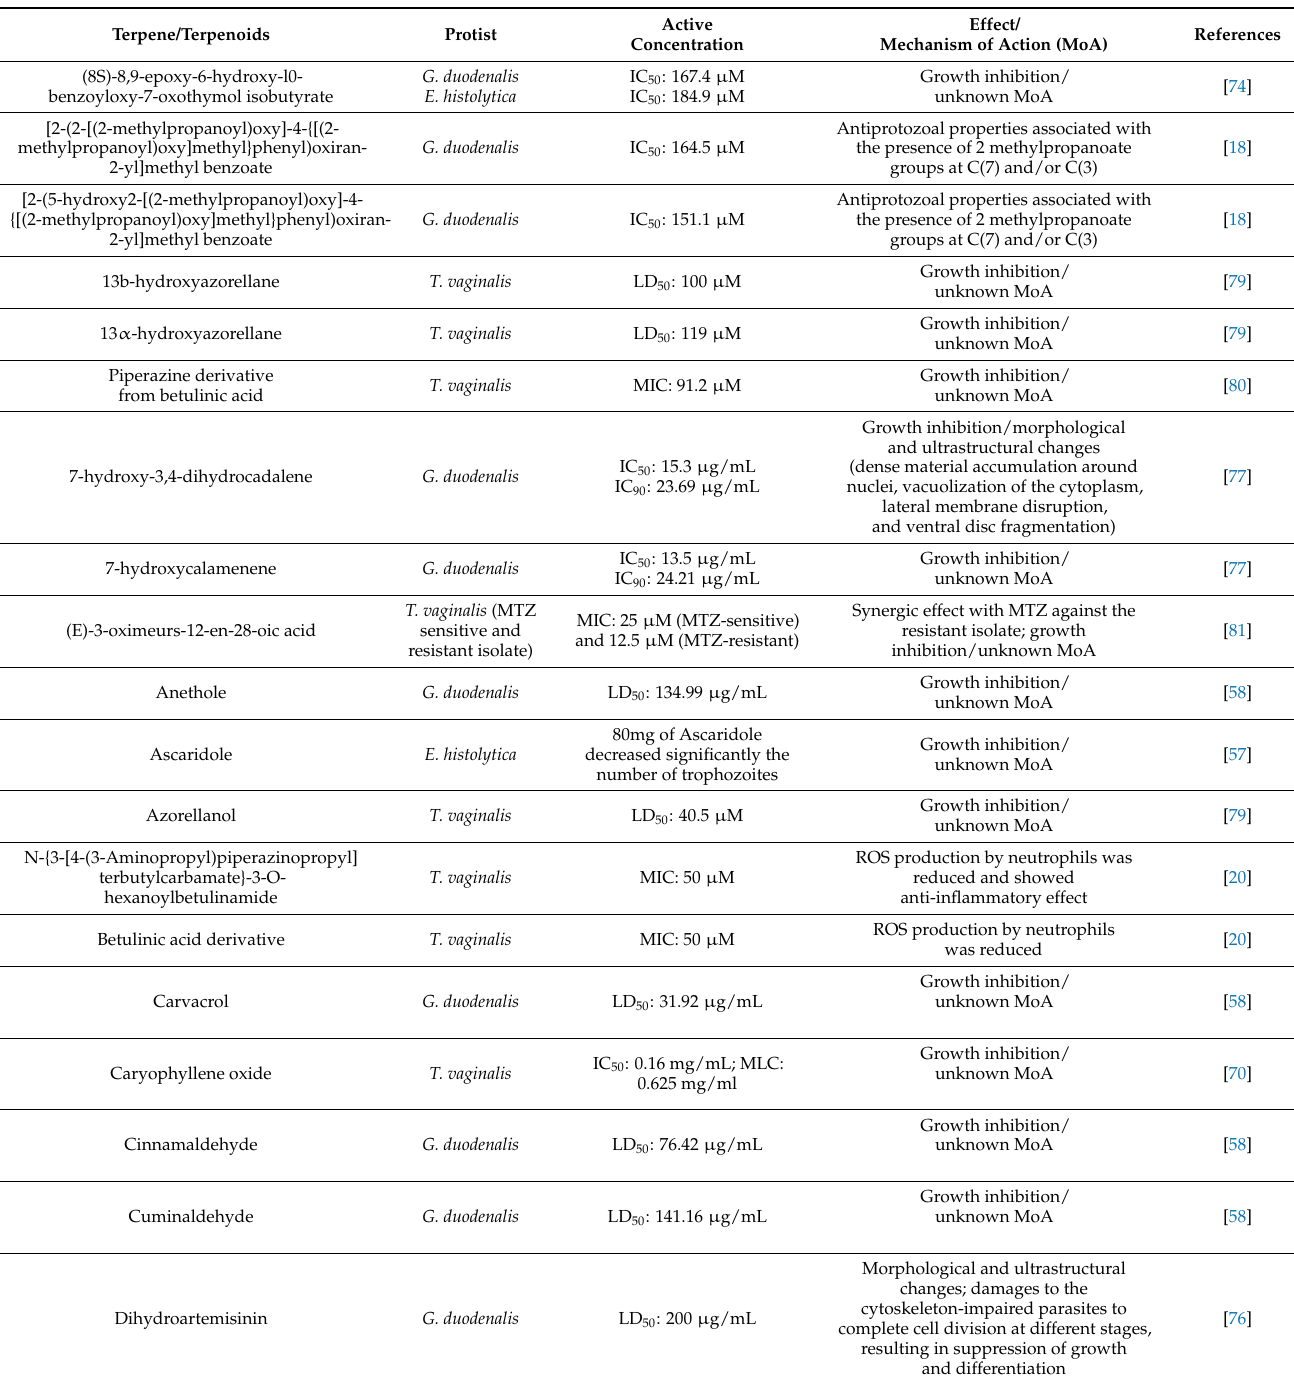
Table 2. Essential oil derivatives with activity against Giardia duodenalis , Entamoeba histolytica , and Trichomonas vaginalis . (To be